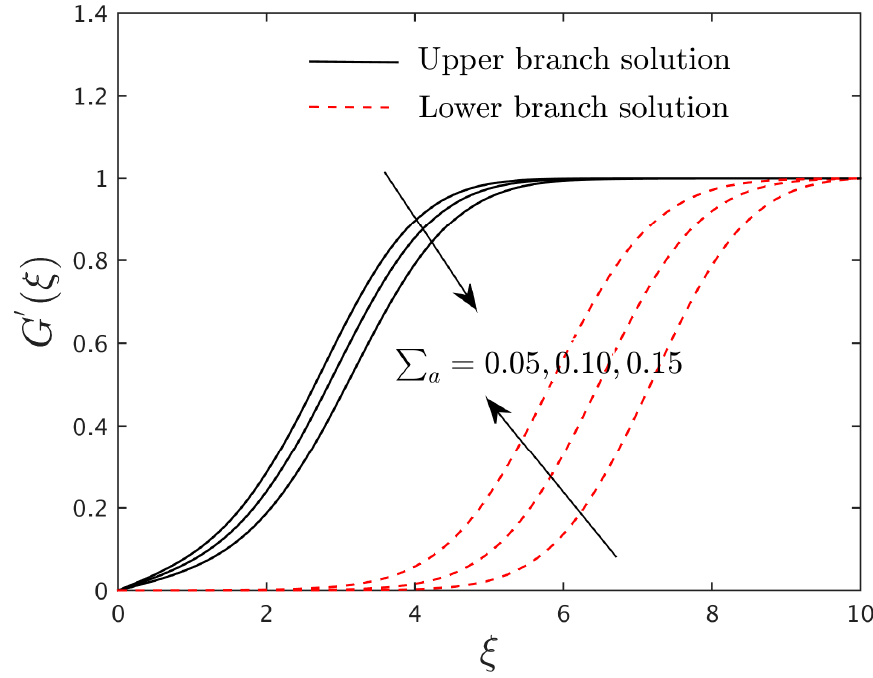
Figure 9. The induced magnetic profiles G (cid:48) ( ξ ) for the numerous values of Σ a when Pr a = 1.0, Sc a = 10.0, Pr = 6.2, ϕ = 0.025, and γ s =